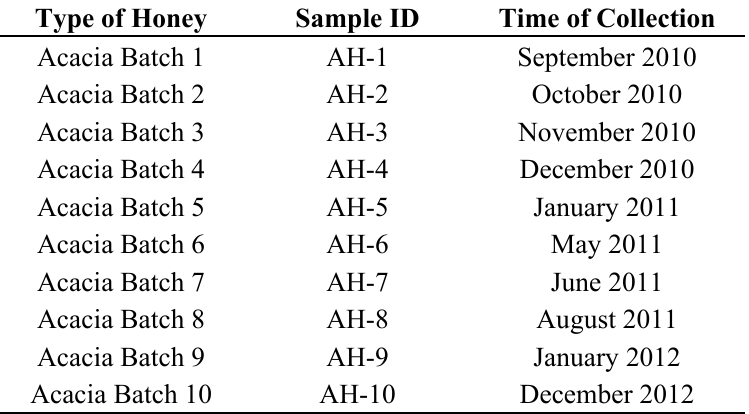
Table 2. Details of the investigated acacia honey